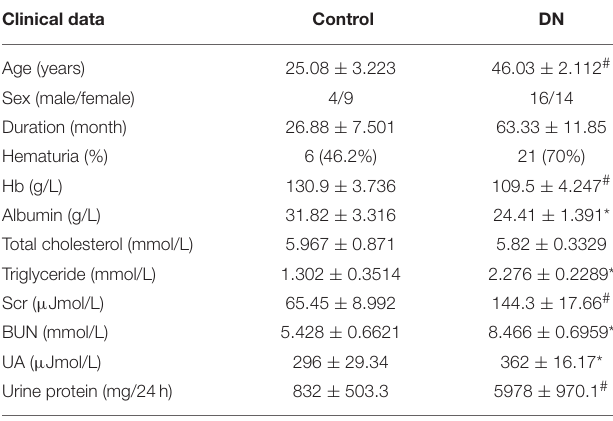
TABLE 1 | Clinical characteristics of the patients with DKD and non-DKD.